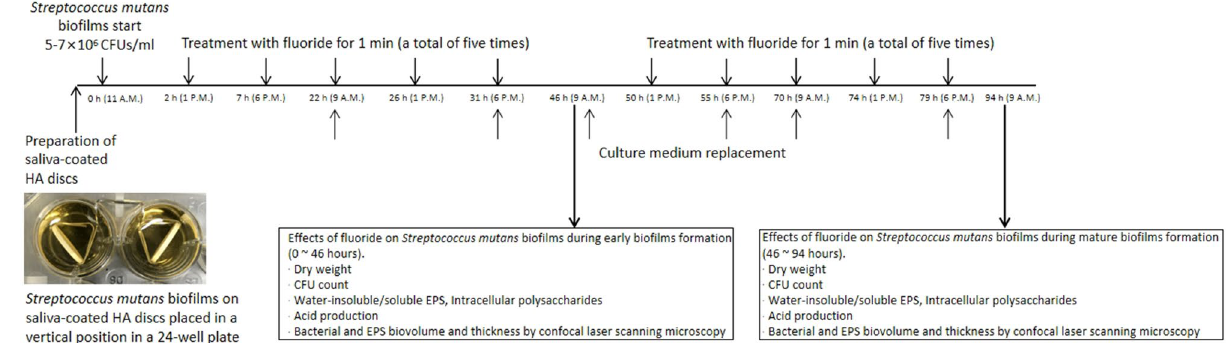
Figure 6. Streptococcus mutans biofilms formation and experimental